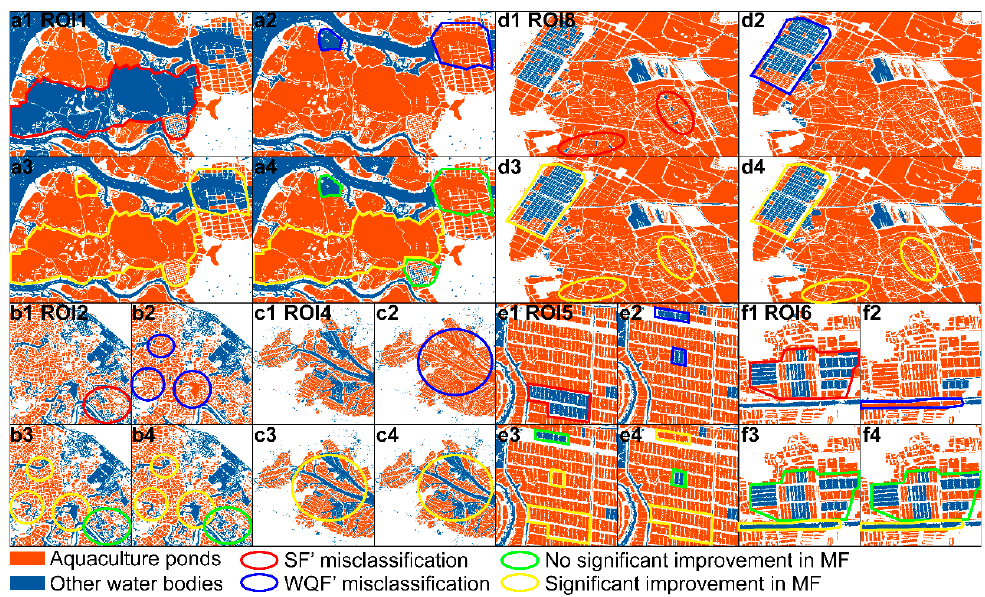
Figure 6. The performance of the four test feature combinations on sites 1, 2, 4, 5, 6, and 8; ( a1 – a4 ) represents the SF, WQF, MFNRFE, and MFRFE classification results, same for ( b1 – f4 ).